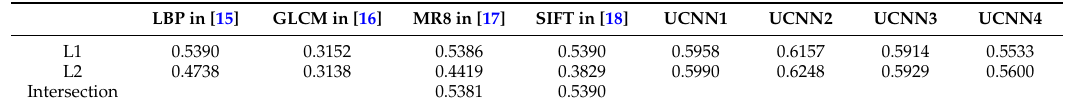
Table 2. Dataset-level precision (DP) using different single features.